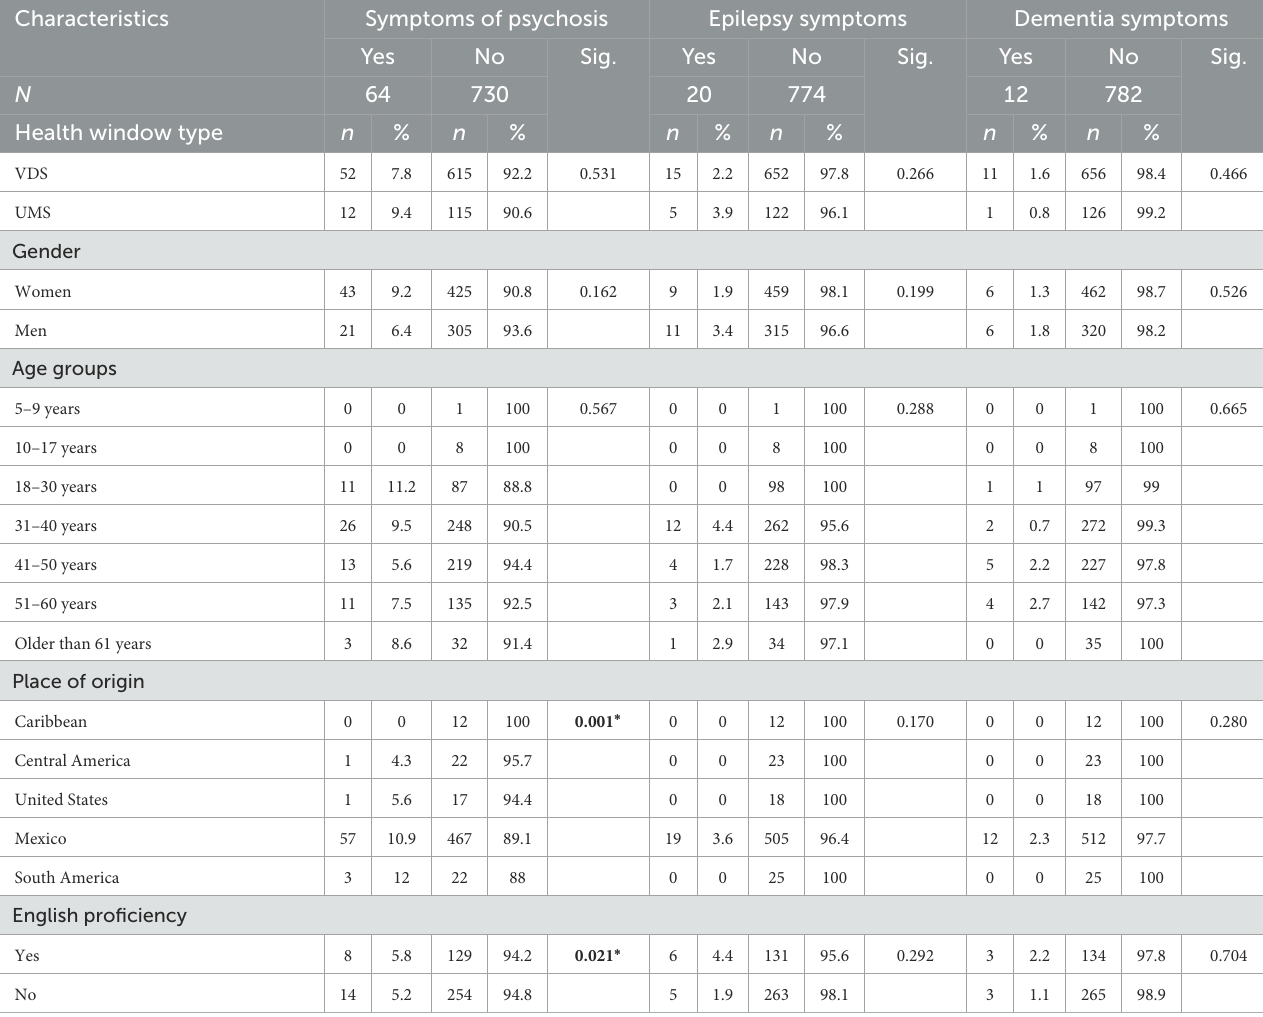
TABLE 3 Distribution of sociodemographic characteristics among the population with or without mental health symptoms/problems of psychosis, epilepsy, or dementia for screenings done at HW and MHU during 2021.